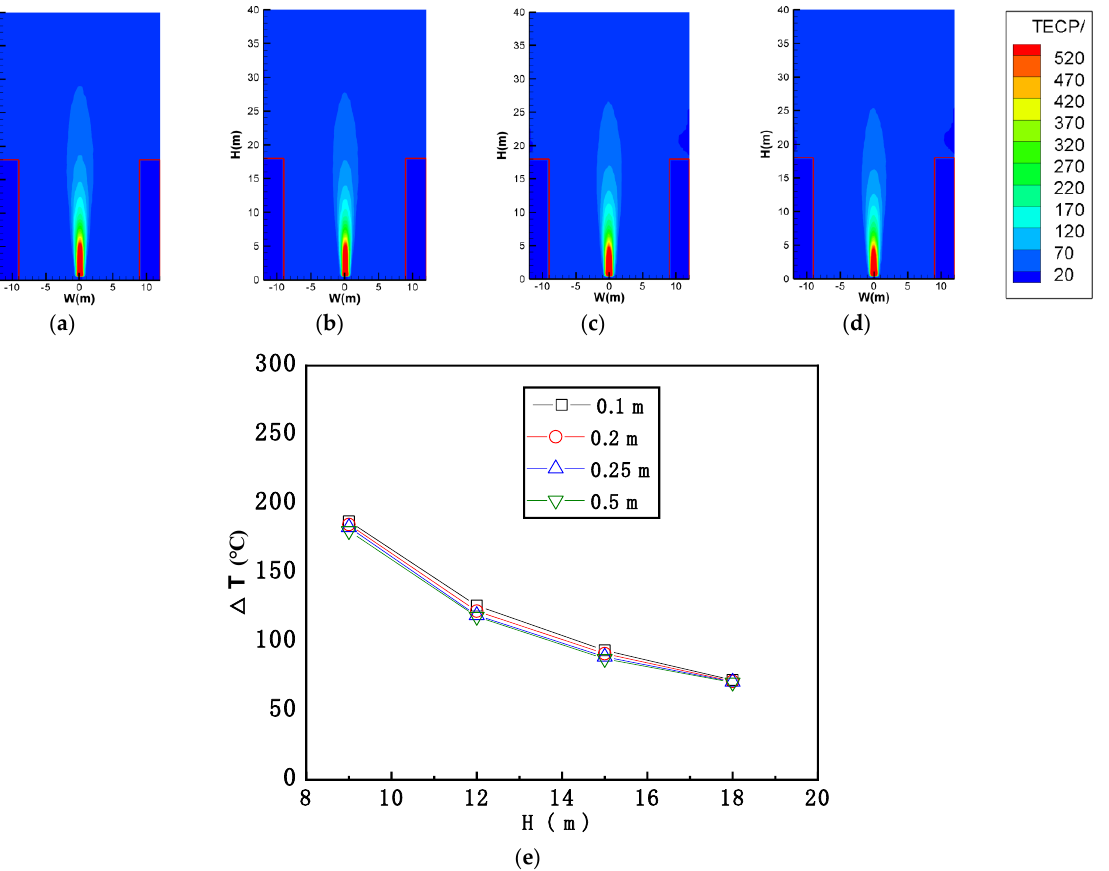
Figure 2. Temperature comparison for grid − sensitivity check: ( a ) grid size of 0.1 m × 0.1 m × 0.1 m; ( b ) grid size of 0.2 m × 0.2 m × 0.2 m; ( c ) grid size of 0.25 m × 0.25 m × 0.25 m; ( d ) grid size of 0.5 m × 0.5 m × 0.5 m; ( e ) temperature rise at Z = 9 m, 12 m, 15 m and 18 m above the center of fire source with different grid sizes.